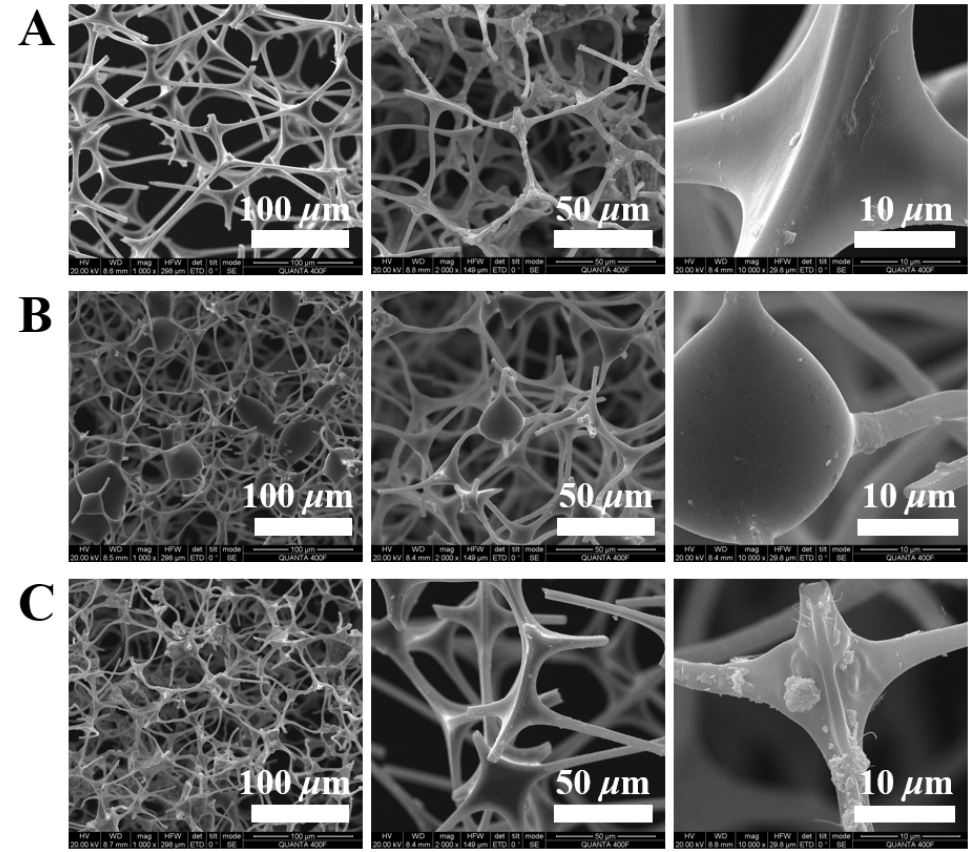
Figure 2. SEM images of MS ( A ), AS@MS ( B ), and m-AS/Kaolin@MS ( C ).